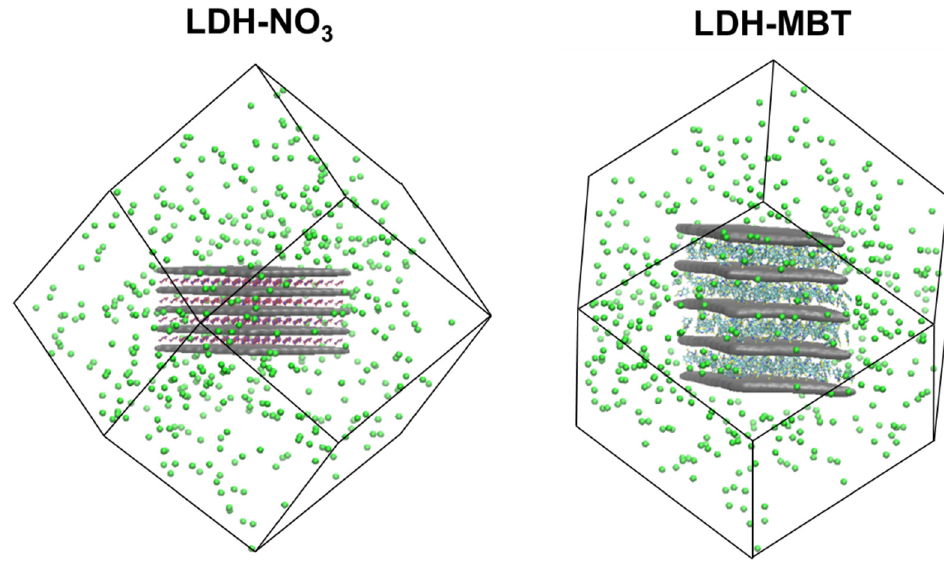
Figure 1. Initial models of LDH-NO 3 ( left ) and LDH-MBT ( right ) were used to perform the release kinetics MD simulations. The cationic layer isosurface is presented in grey, chloride atoms in green, nitrogen in blue, oxygen in red, carbon in turquoise, sulphur in yellow, and hydrogen in